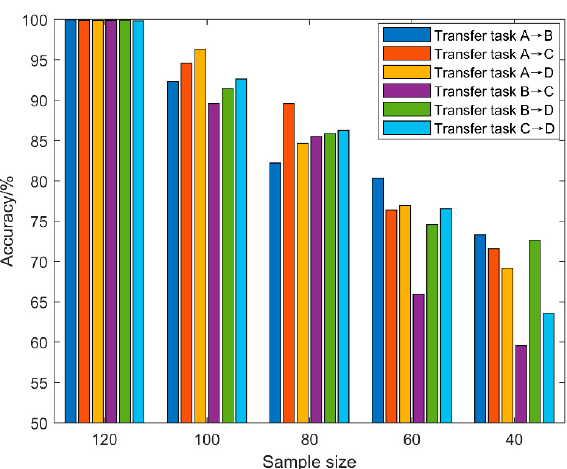
Figure 19. Diagnostic performance graph of the algorithm under different sample sizes.